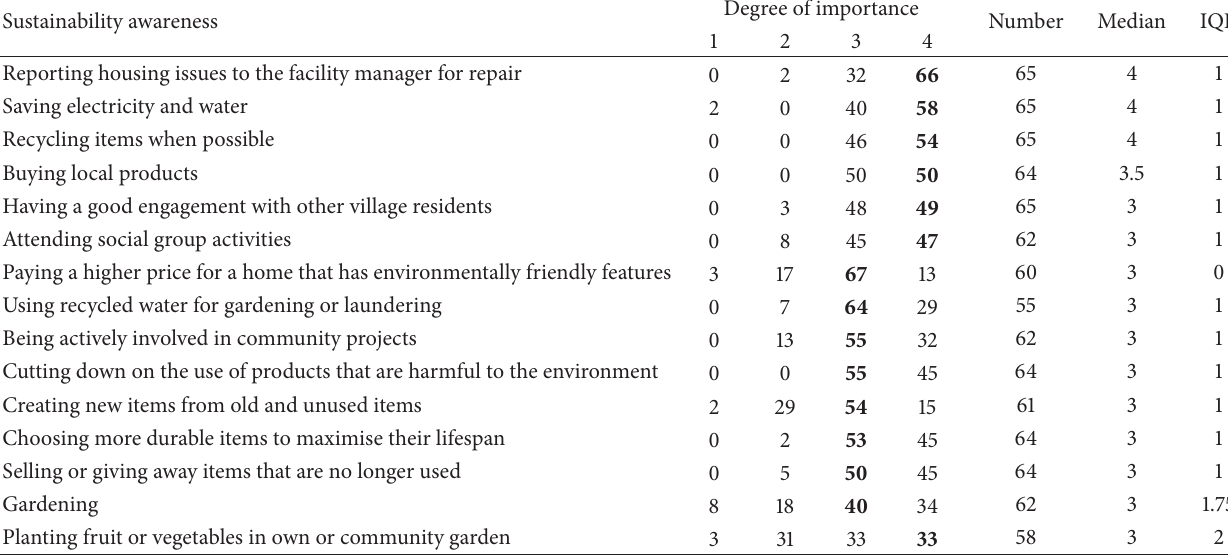
Table 2: Percentage of respondents agreeing on the importance of sustainability